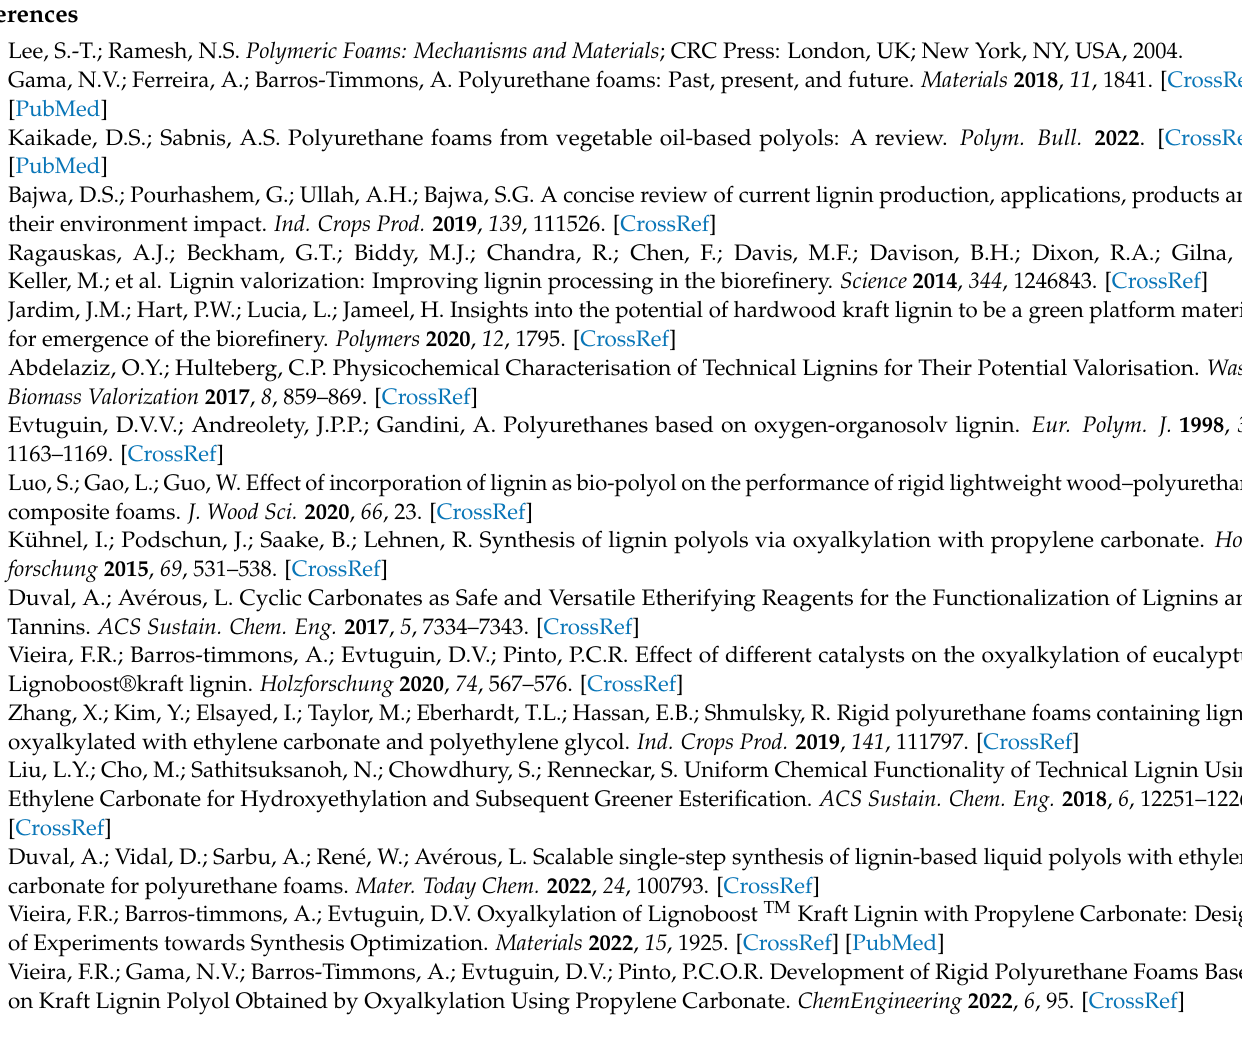
Figure S3: Plots of residual versus predicted values for (a) thermal conductivity and, (b) density obtained from reduced model; Figure S4: (a) Effect test for thermal conductivity, (b) Effect test for density; Table S1: ANOVA results for the empirical regression models for thermal conductivity and density; Video S1: Bio-based RPUF and